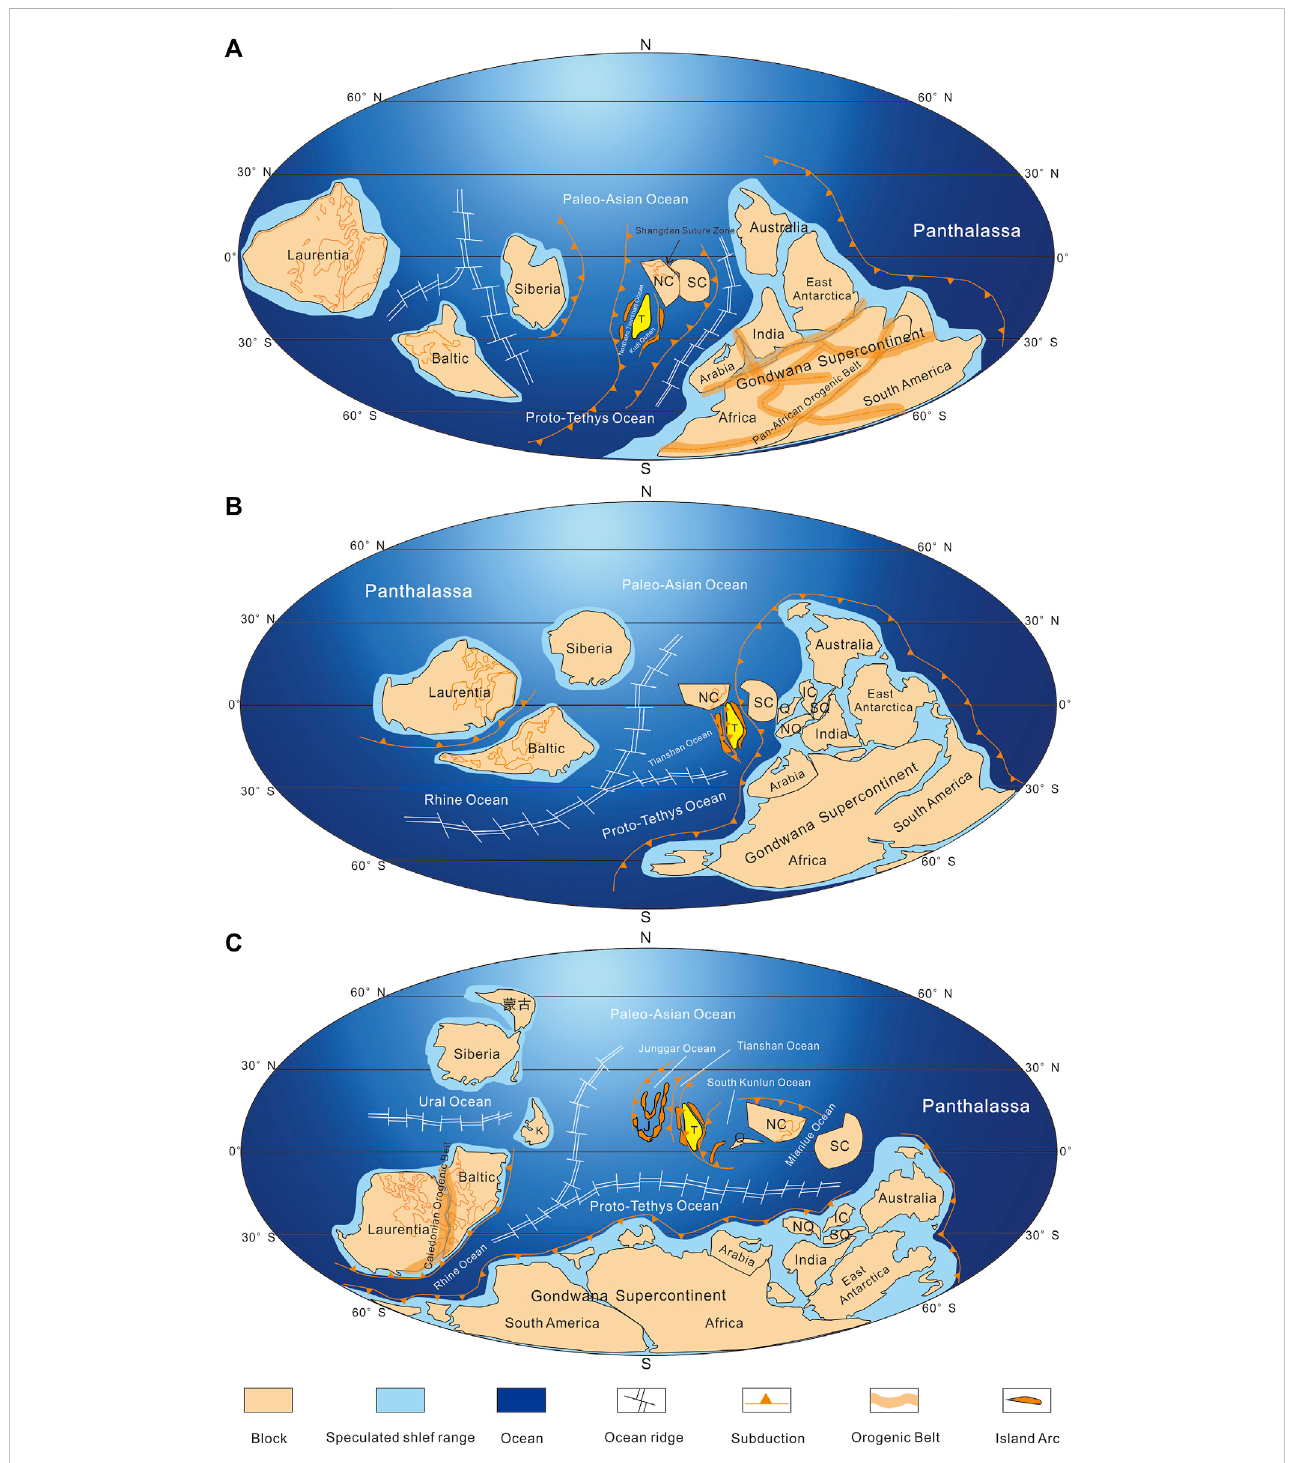
FIGURE 2 Reconstructing of global plates distribution in Cambrian Period (A) , Ordovician Period (B) , and Silurian Period (C) . T-Tarim; NC-North China; SC-South China;Q-Qaidam;NQ-NorthQiangtang;IC-Indochina;SQ-SouthQiangtang;J-Junggar;K-Kazakhstan.(modi fi edafterHuangetal.,2018;Zhaoetal.,2018).